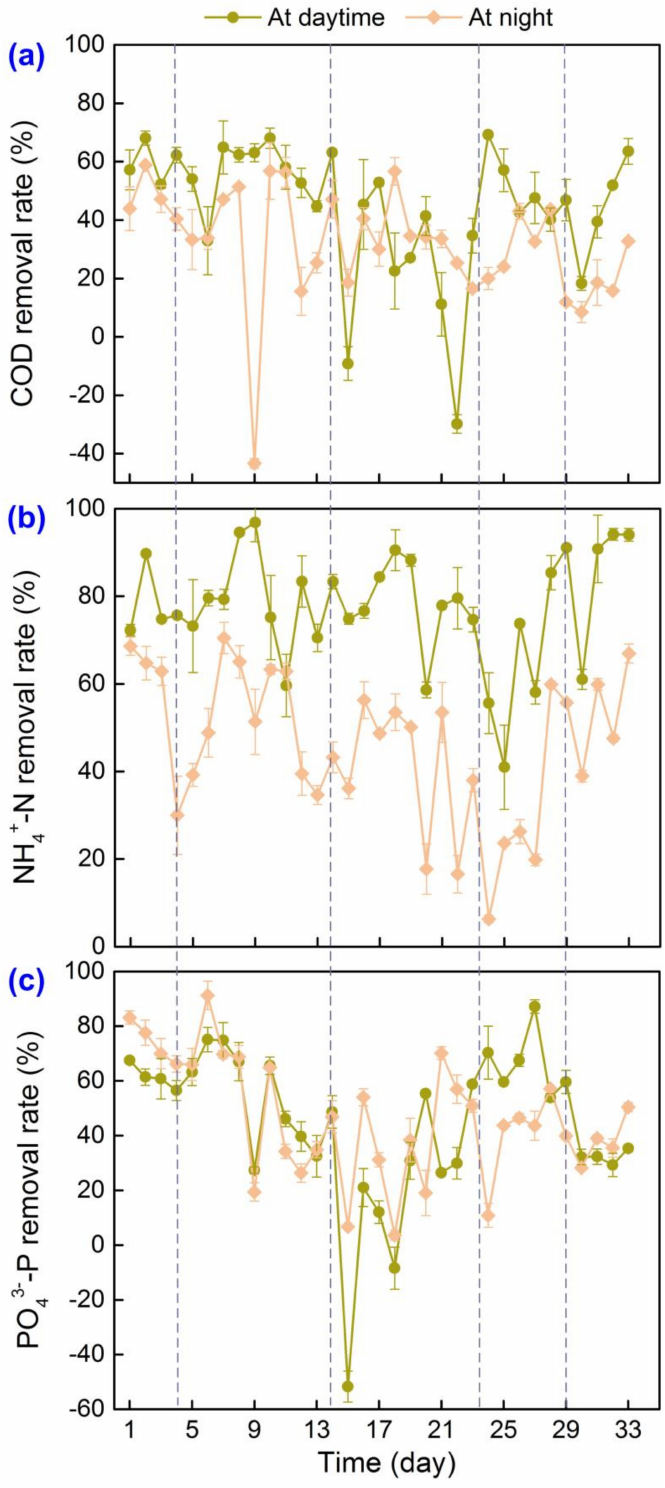
Figure 3. Removal rates of ( a ) COD, ( b ) NH 4 + -N and ( c ) PO 4 3 −